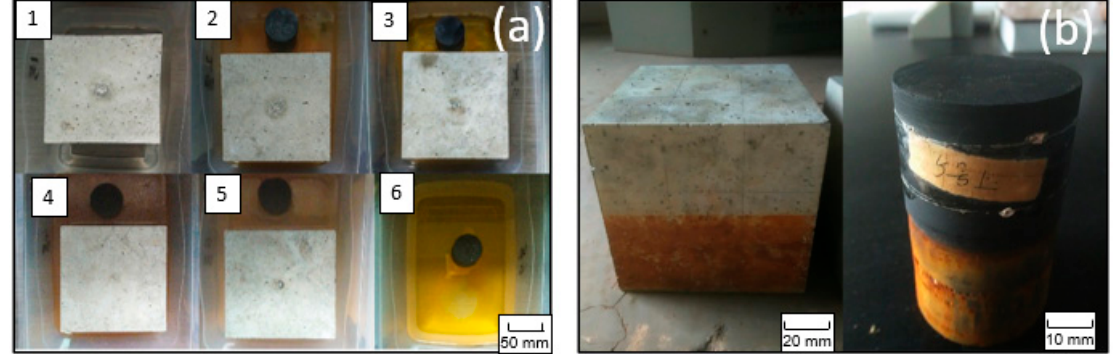
* non-detectable (n.d.).